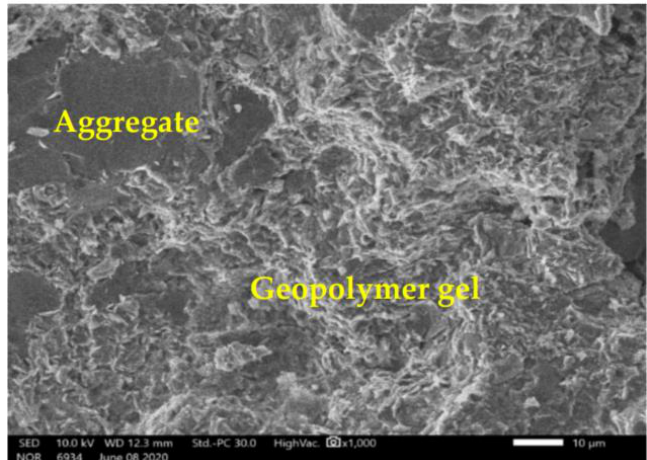
Figure 11. Development of geopolymer gels in GRAC.